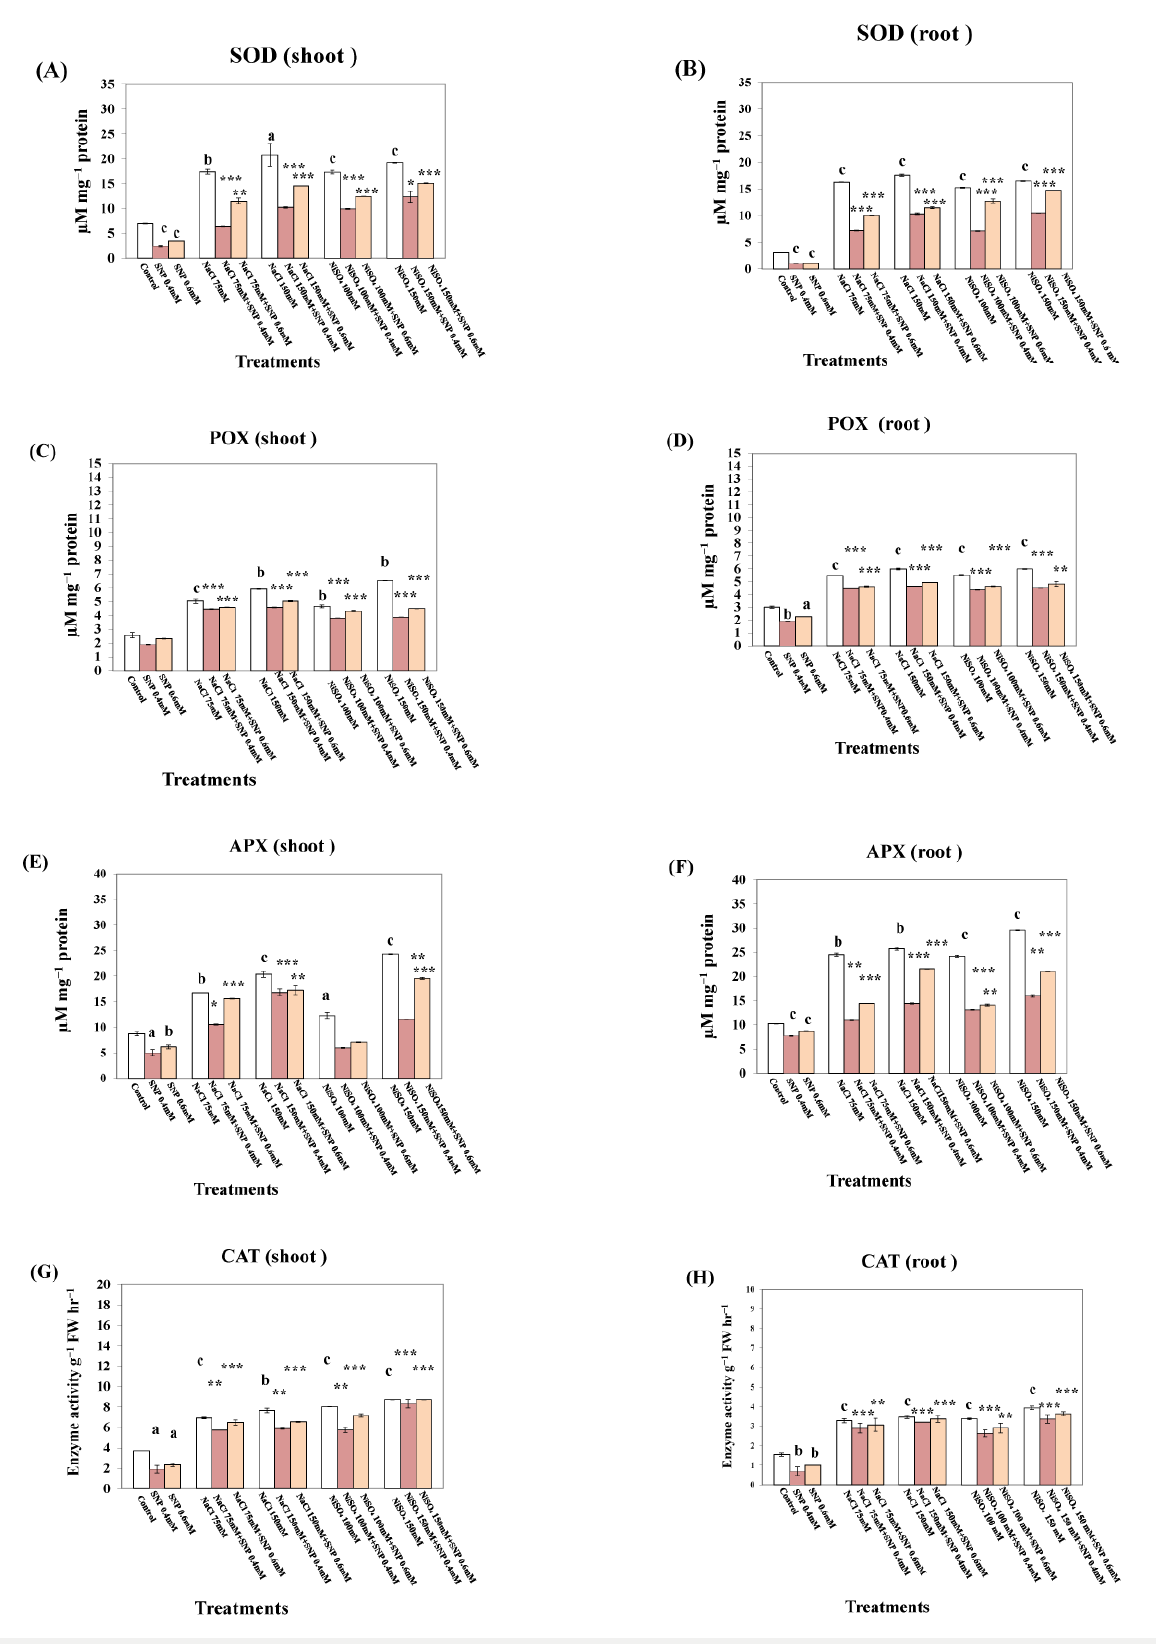
Figure 1 Effect of sodium nitroprusside (SNP) (as nitric oxide donor) on superoxidedismutase, peroxidase, ascorbate peroxidase, and catalase activity of Lupinus albus subsp. termis (Forssk.) Ponert, under sodium chloride (0 ,75, and 150 mM) and nickel sulphate (0, 100, and 150 mM) stress. Data are mean ± SE (standard error) of five replicates. Values with letters are significantly different from the control (tap water). Letter “a” at p < 0.05 (significant), “b” at p < 0.01 (highly significant), “c” at p < 0.001 (extremely significant), and no letter = nonsignificant. Values with asterisks are significantly different from the SNP control (0.4 mM, 0.6 mM). Asterisks * at p < 0.05 (significant), ** at p < 0.01 (highly significant), *** at p < 0.001 (extremely significant), and no asterisks =